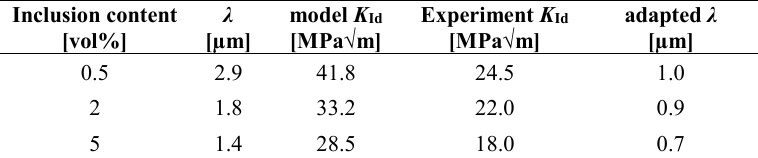
Table 2. Comparison of experimental and theoretical